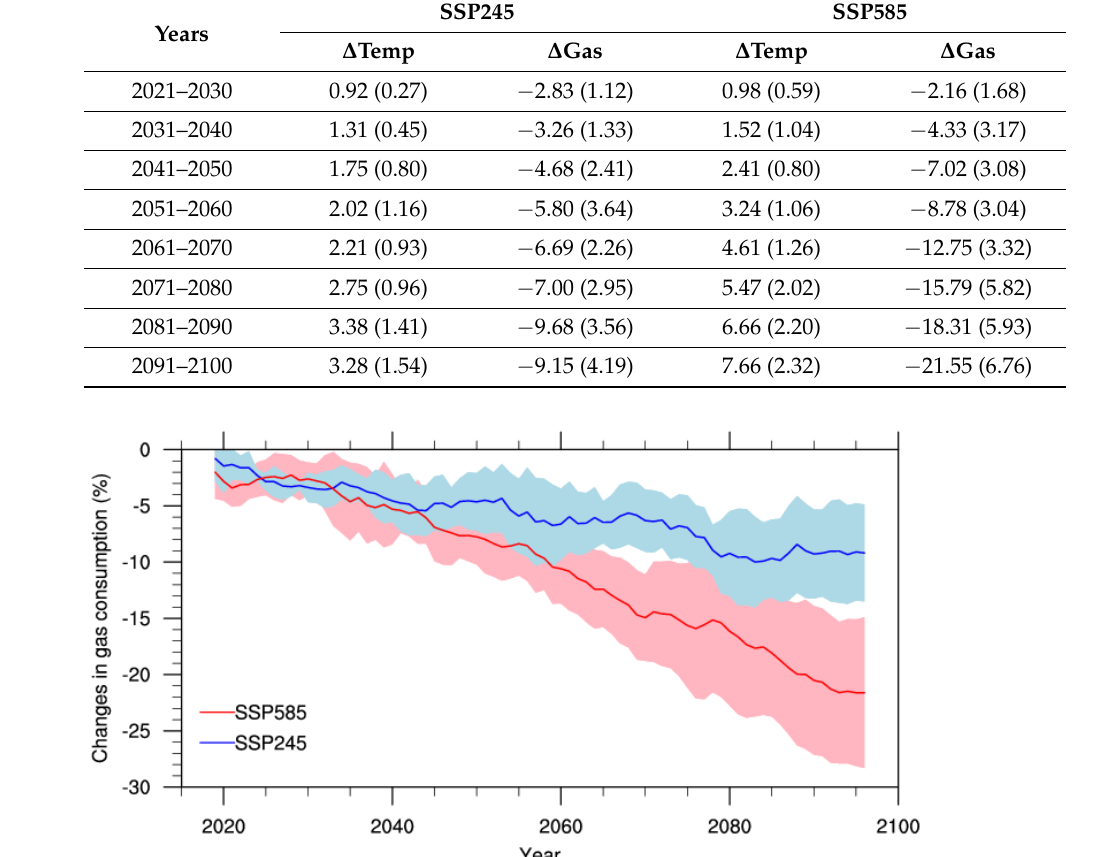
Figure 5. Percentage changes in the 9 year smoothed natural gas consumption with respect to tem- perature changes under the SSP245 (blue line) and SSP585 (red line) scenarios during heating season for the period of 2015–2100 (relative to 1995–2014) in Beijing. Shadings denote the model spread.